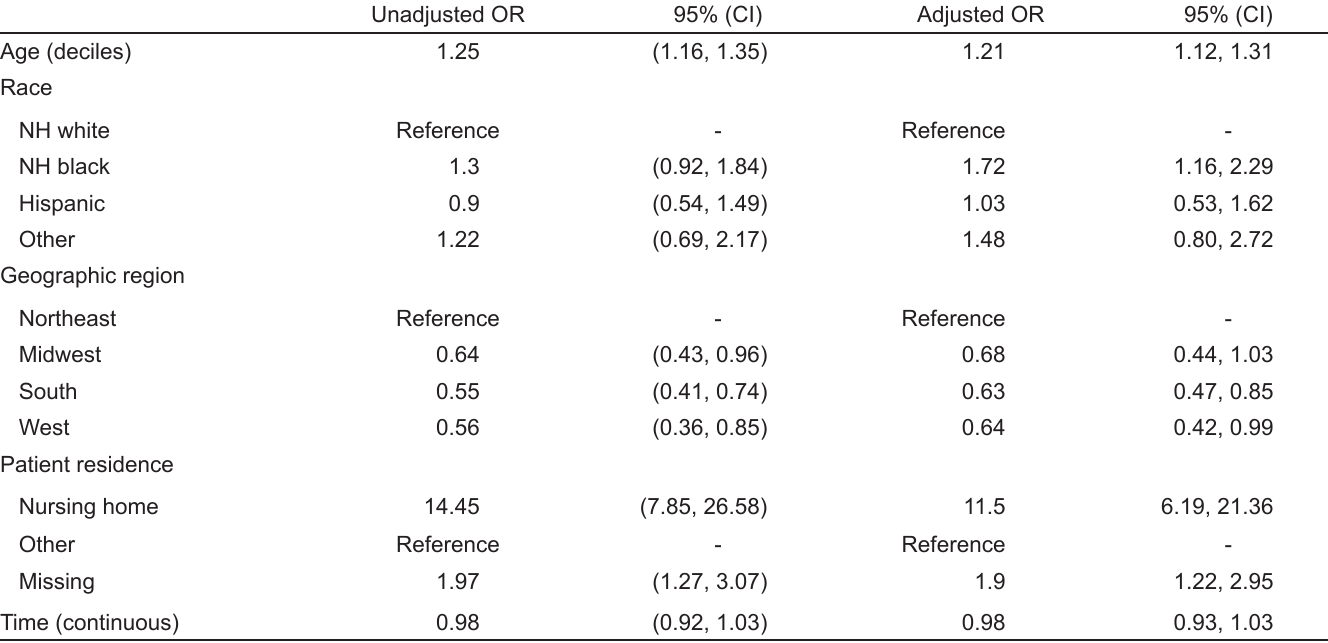
NH , non-Hispanic